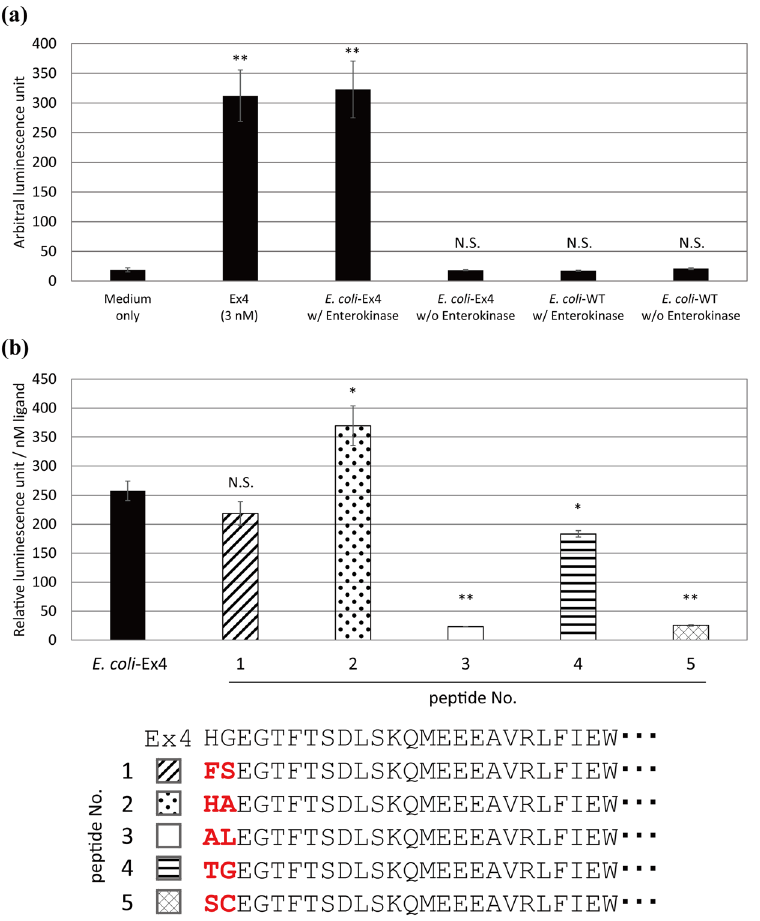
Figure 6. Functional evaluation of Exendin-4 (Ex4) variants produced by E . coli. ( a ) The functional assay using WT Ex4 produced by E . coli . We cultured E . coli producing WT Ex4 fused with a FLAG sequence at the N-terminal ( E . coli -Ex4) and WT E . coli ( E . coli -WT). The cell lysates were purified using anti-FLAG resin, reacted with or without enterokinase, and assayed with the adherent hGLP1R/NLuc-293 cells. DMEM media with or without 3 nM authentic Ex4 were used as a positive control and a negative control. Values are mean ± SD (n = 3). Two-tailed Student’s t -test was used to compare two groups ( ** p < 0.01). N.S., not significant. ( b ) Activities of each of the Ex4 variants produced by E . coli . Relative luminescence units were corrected based on concentrations of each peptide. Values are mean ± SD (n = 3). Two-tailed Student’s t -test was used to compare two groups ( * p < 0.05, ** p < 0.01). N.S., not